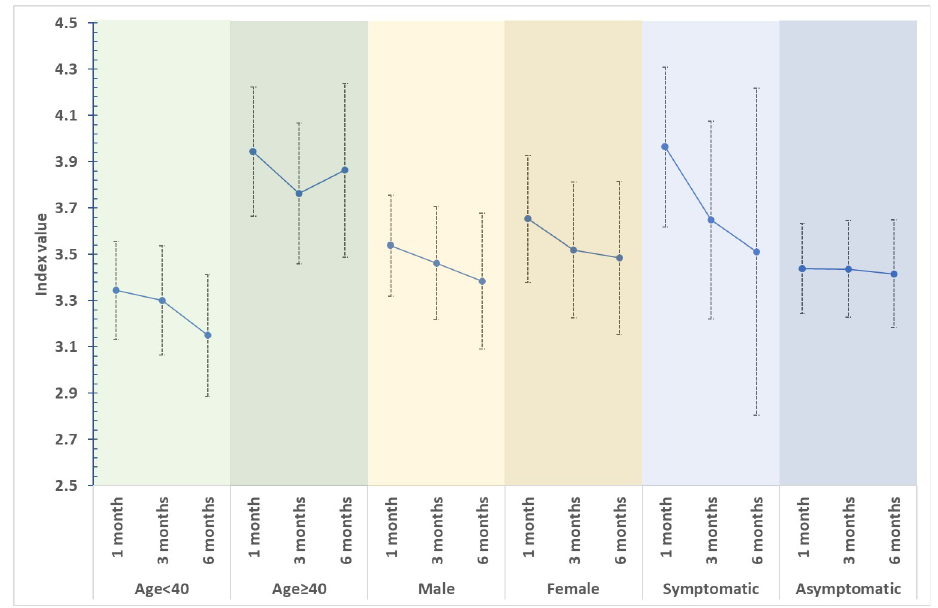
Fig 3. Mean difference in IgG index value, 30 days, 90 days, and 180 days after initial NPS test positivity across age, gender and symptoms.